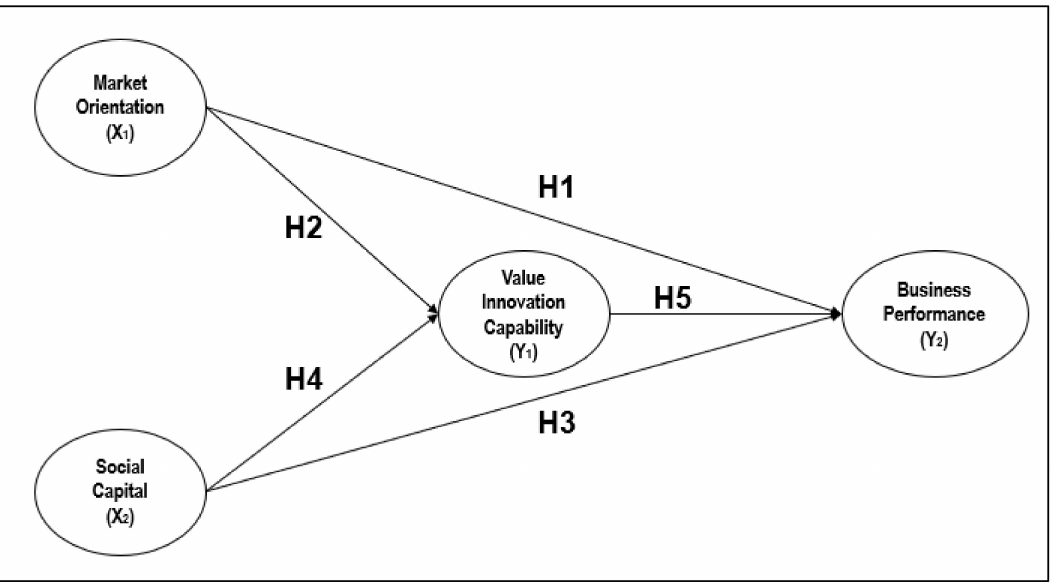
Figure 1. Concept framework, adoption of the model